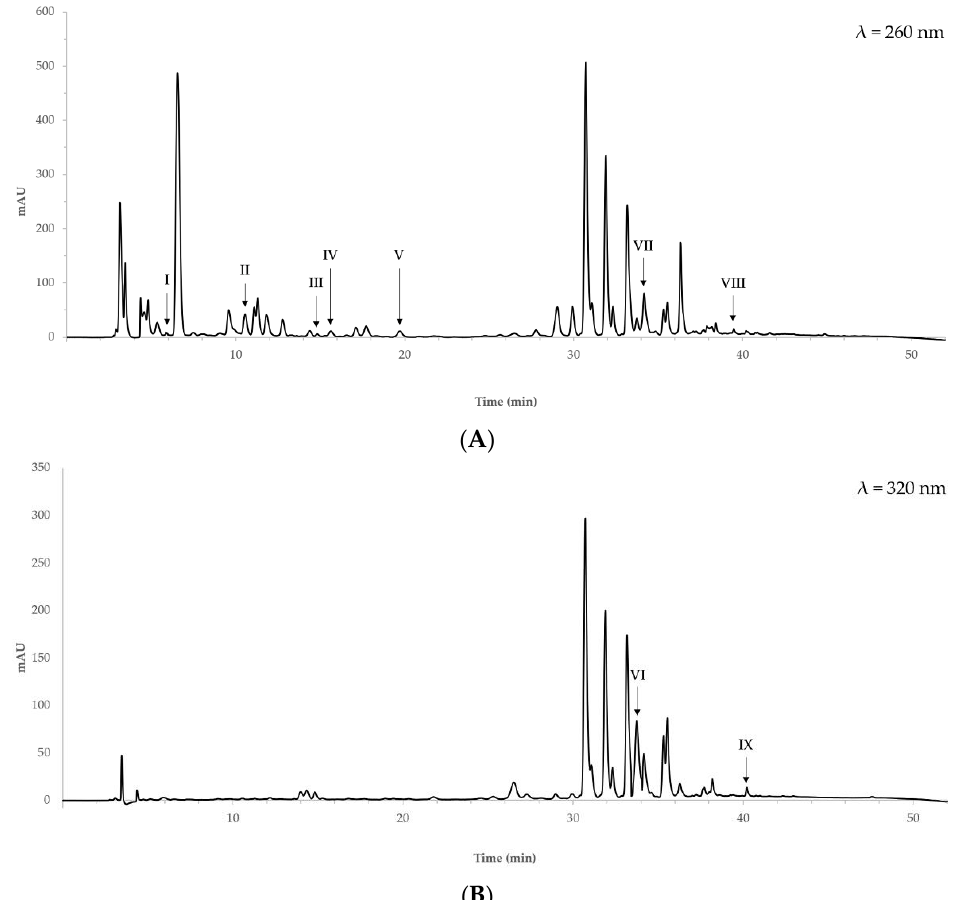
Figure 3. Chromatograms of quinoa phenolic extract in methanol/acetone aqueous solutions at 260 nm ( A ) and 320 nm ( B ). I: gallic acid, II: protocatechuic acid, III: (+)-catechin, IV: 4-hydroxybenzoic acid, V: vanillic acid, VI: t -ferulic acid, VII: rutin, VIII: o -coumaric acid, IX: 3,4-dimethoxycinnamic acid.